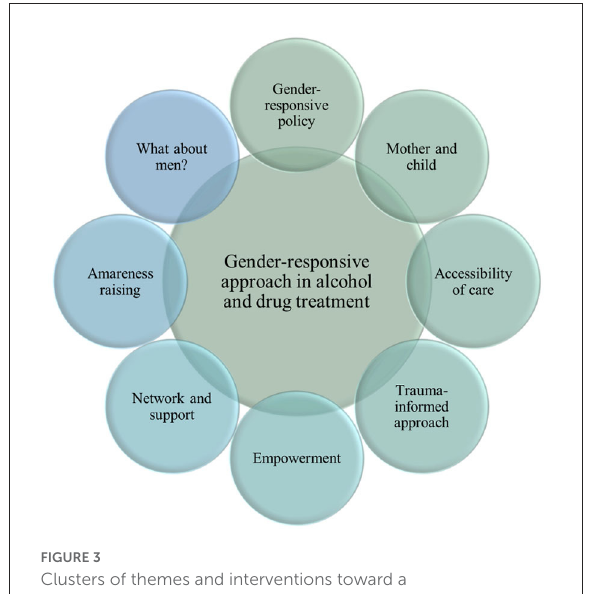
FIGURE3 Clusters of themes and interventions toward a gender-responsive approach in alcohol and drug treatment for